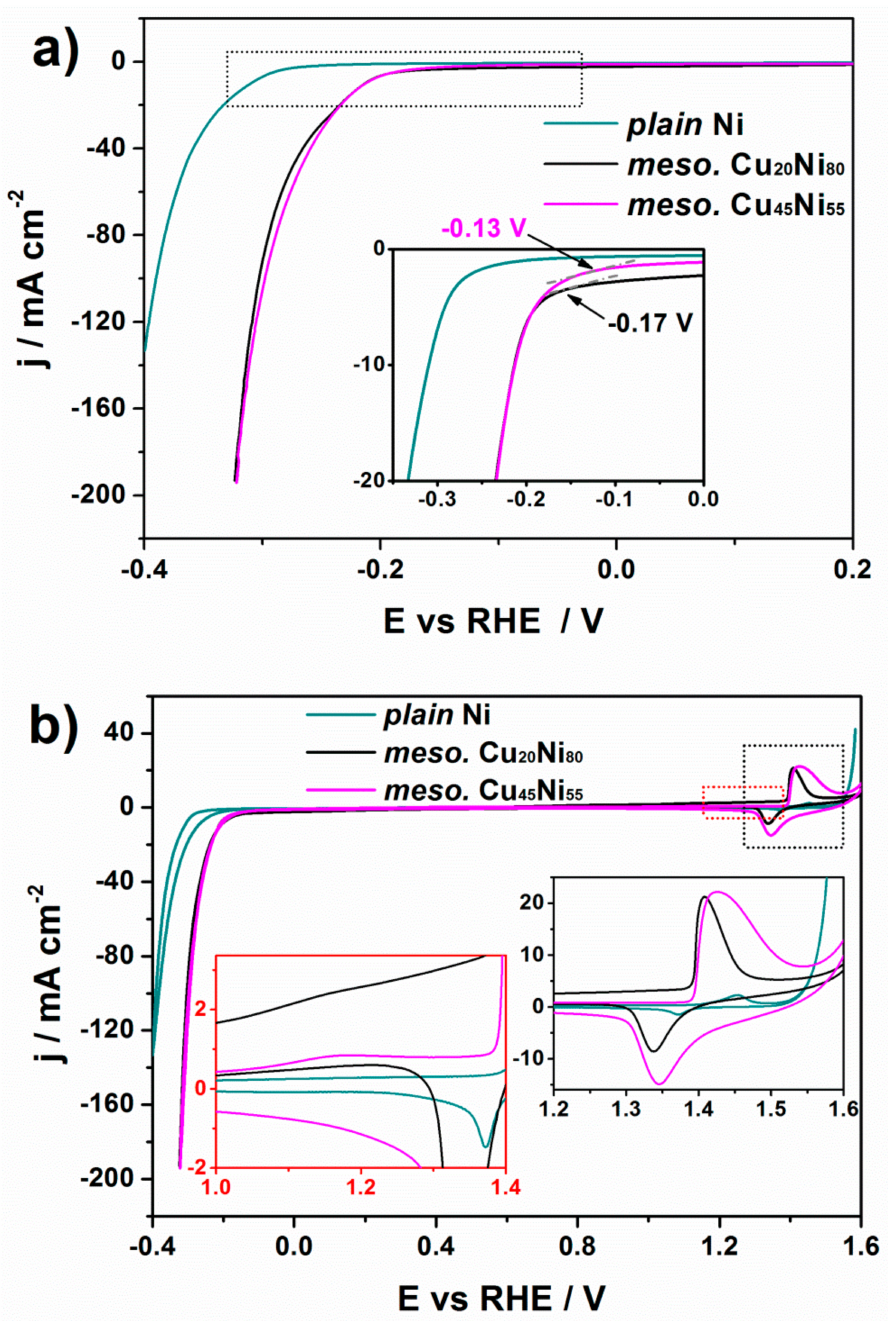
Figure 8. ( a ) Polarization and ( b ) CV curves recorded in 1 M KOH electrolyte for Cu 20 Ni 80 and Cu 45 Ni 55 surface-mesostructured films. The response of a plain pure Ni film is shown for comparison. The inset in ( a ) and right inset in ( b ) show zoomed-in parts of the curves enclosed within the black dotted rectangle. The left inset in ( b ) shows a zoomed-in view of the region enclosed in the red dotted